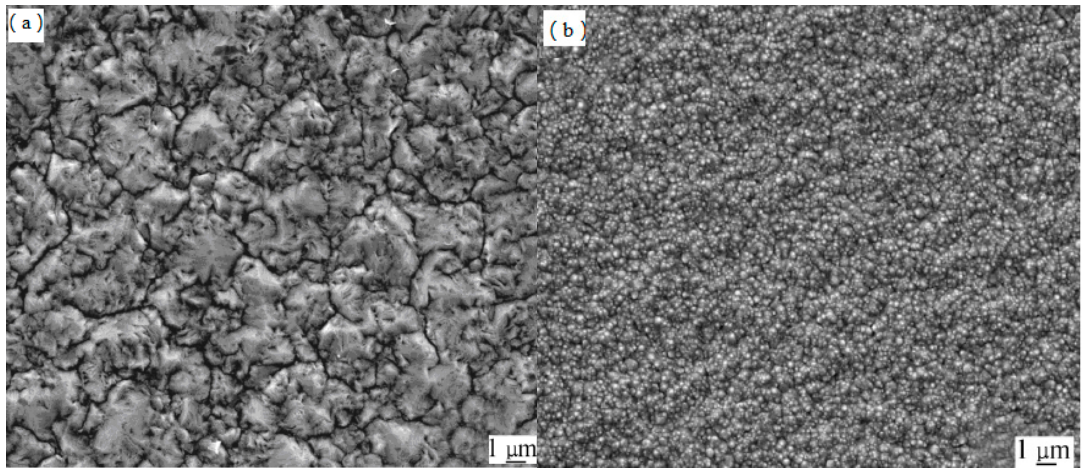
Figure 2. SEM micrographs of electroplating layers: ( a ) Ni layer and ( b ) Ni/n–Al 2 O 3 layer.